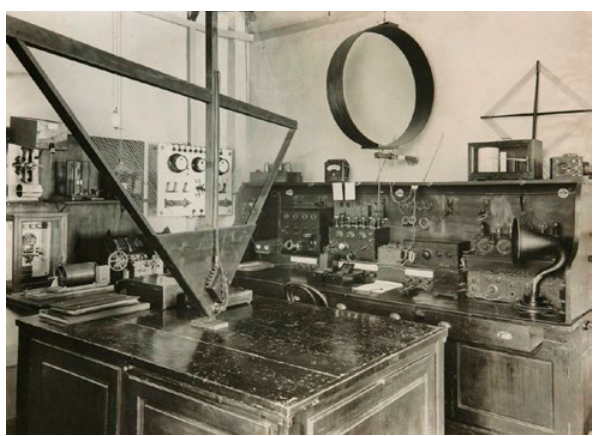
Figure 3. The radiotelegraphy station of Father Alfani at the Xime- niano Observatory. 2